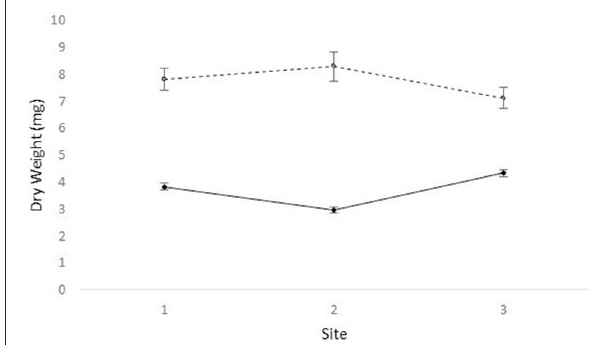
FIGURE 2 | The mean ± dry weight (mg) of individual pollen pellets collected by honey bees (solid line) and bumble bees (dashed line) at sites 1, 2, and